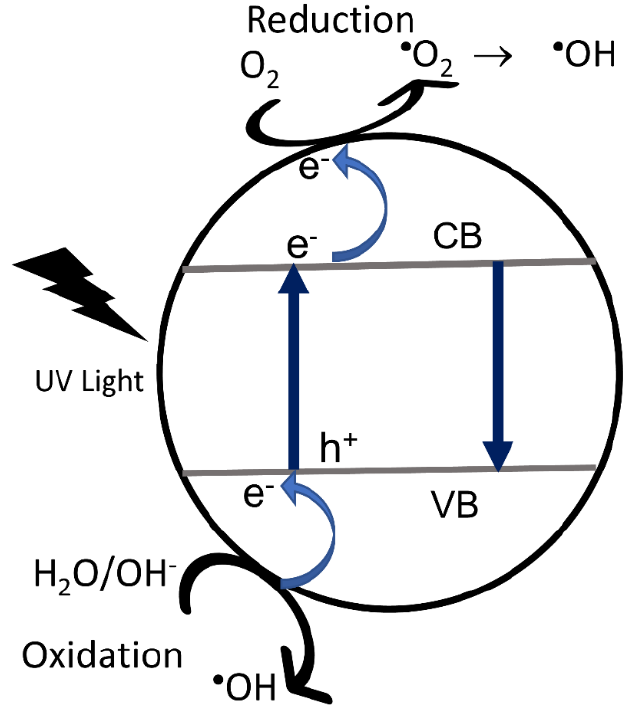
Figure 4. Mechanism of heterogeneous photocatalysis [64].